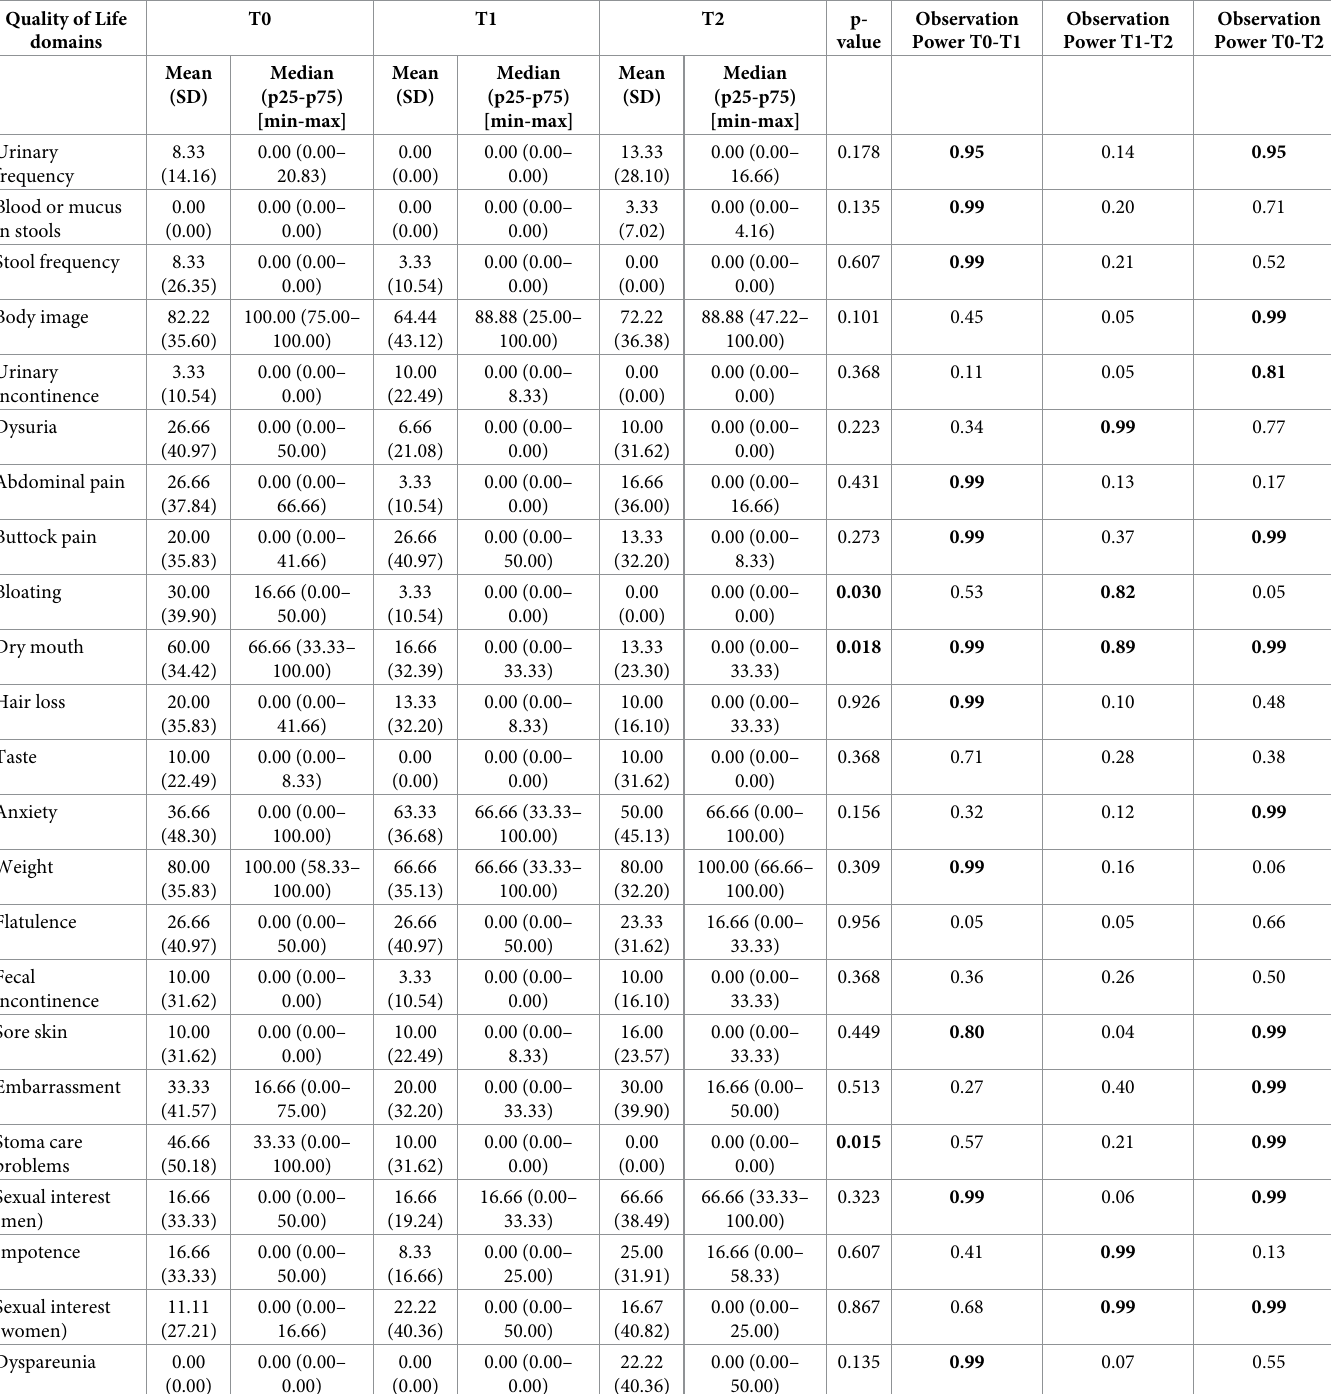
Table 3. Synopsis of EORTC QLQ-CR29 longitudinal score differences and corresponding p-values according to quality of life scales for patients with colostomy due to colorectal